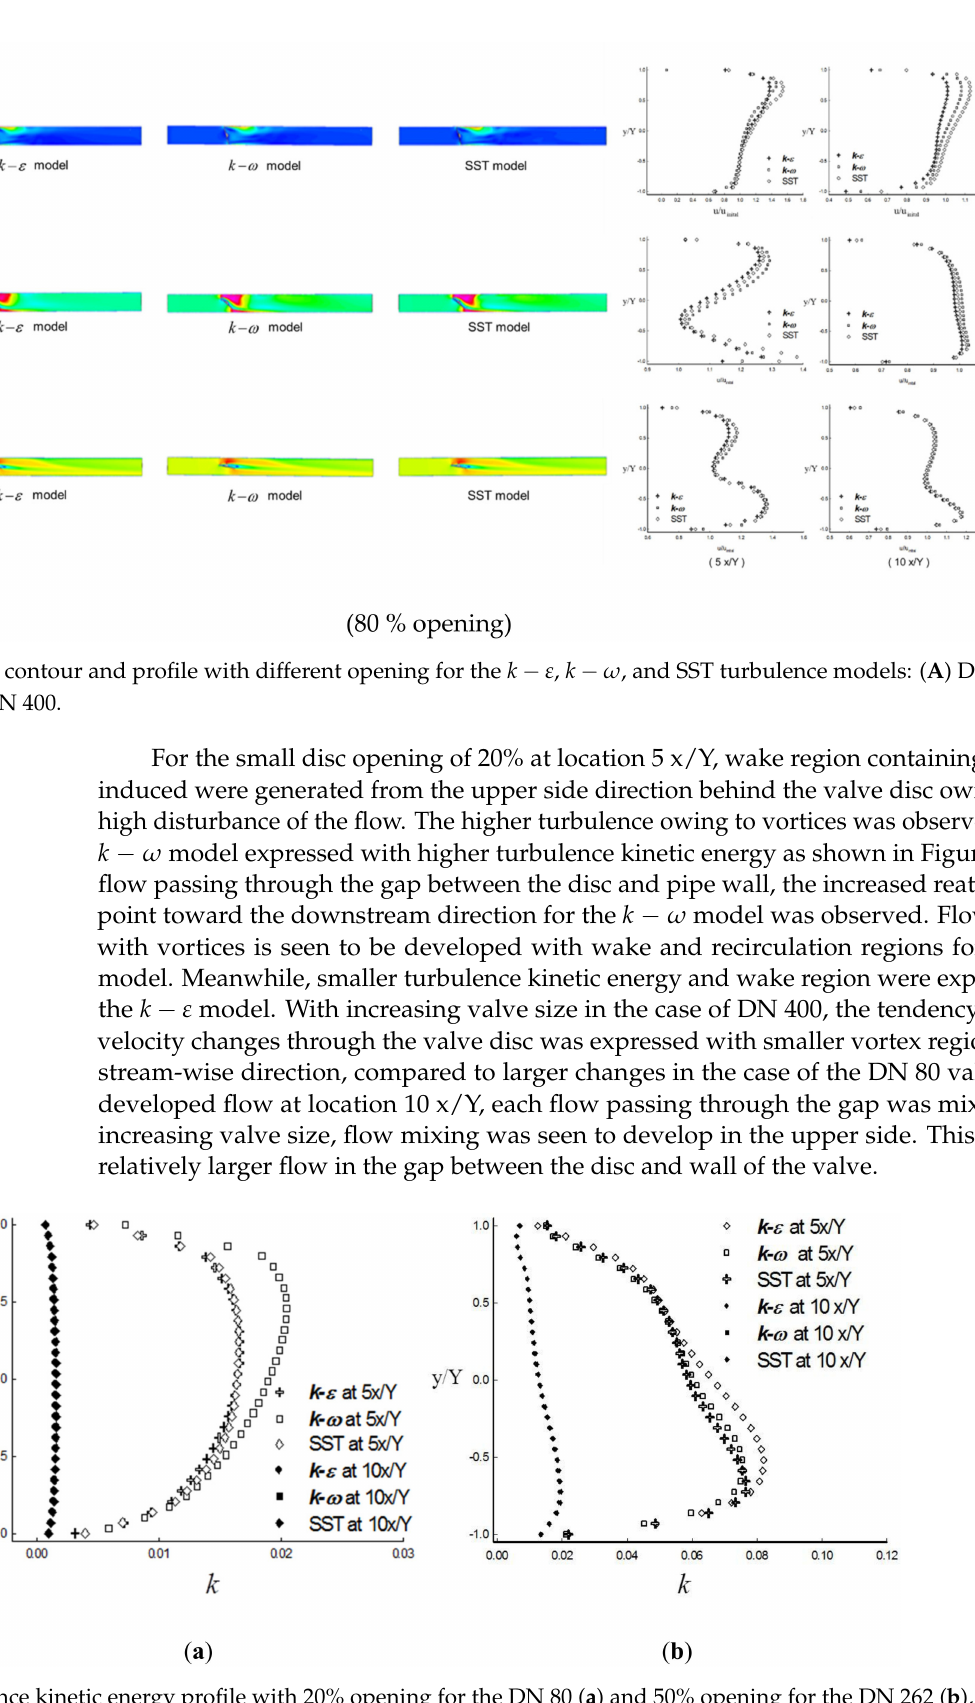
Figure 5. Turbulence kinetic energy profile with 20% opening for the DN 80 ( a ) and 50% opening for the DN 262 ( b ), with different turbulence model of k − ε , k − ω and